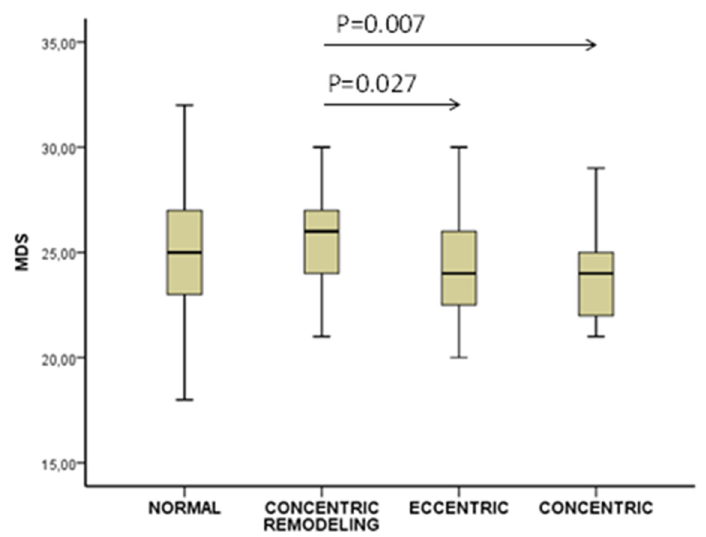
Figure 3. Mediterranean diet score (MDS) by left ventricular geometry patterns.